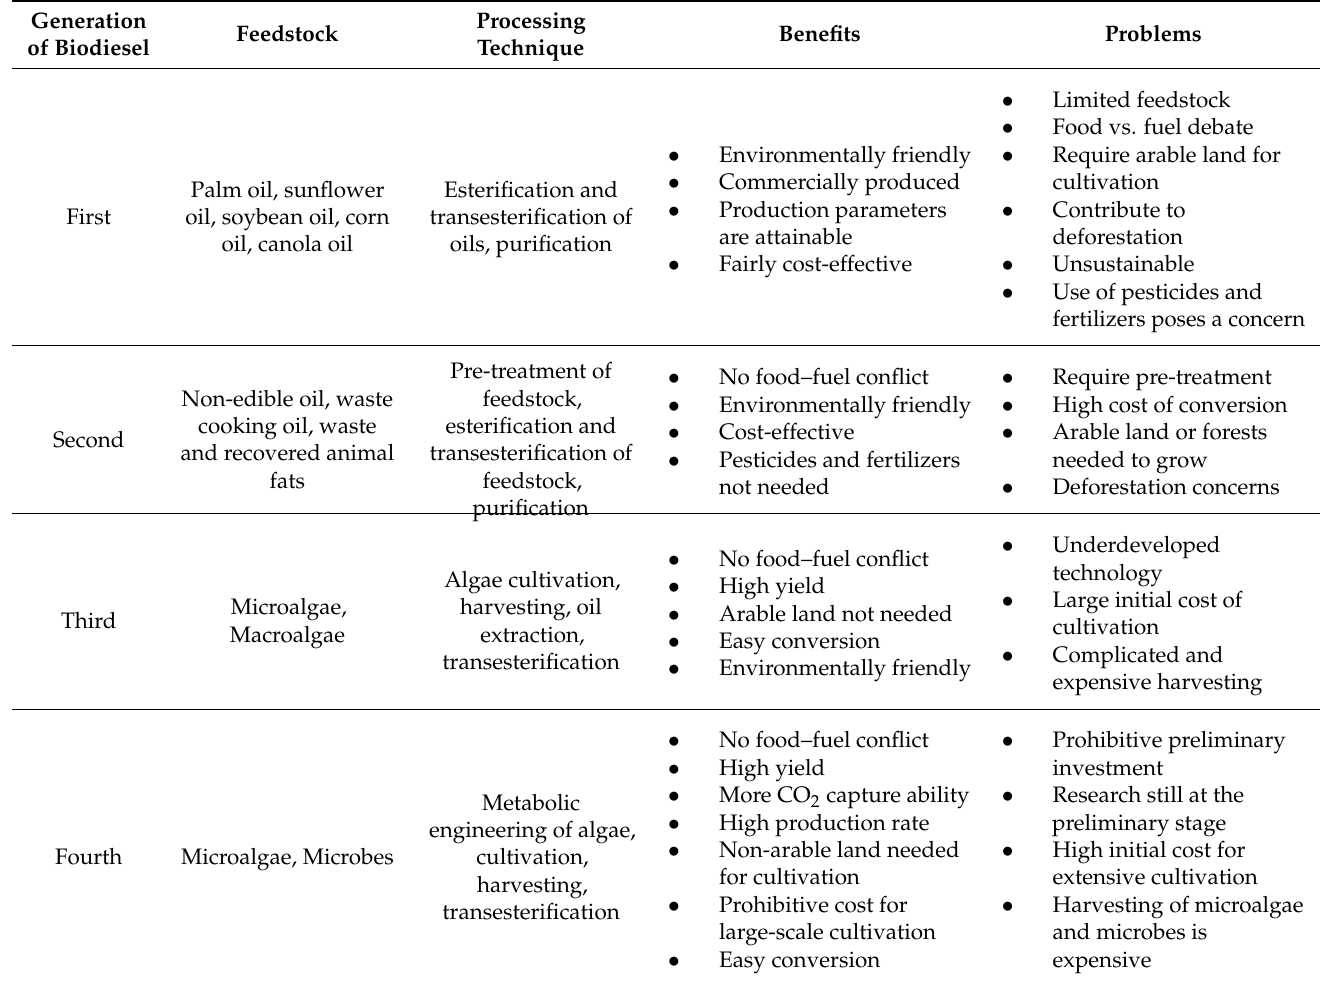
Table 7. Comparison of the four generations of biodiesel